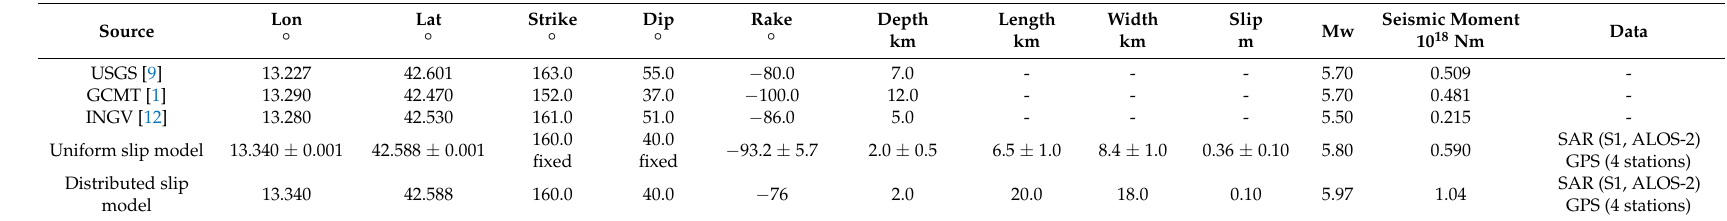
Table 6. Source parameters of the 18 January 2017